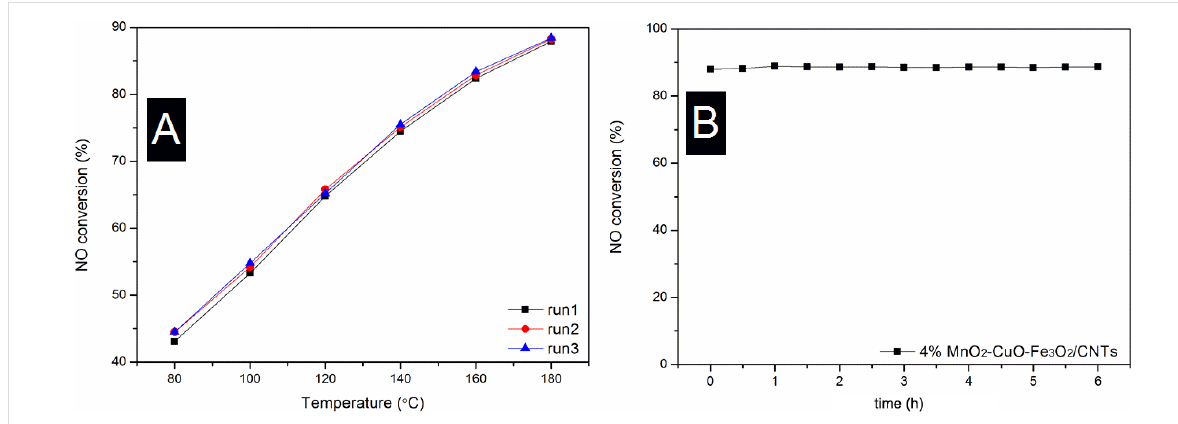
Figure 8: Cyclic and long-term stabilities of 4% MnO 2 –CuO–Fe 2 O 3 /CNTs catalyst.